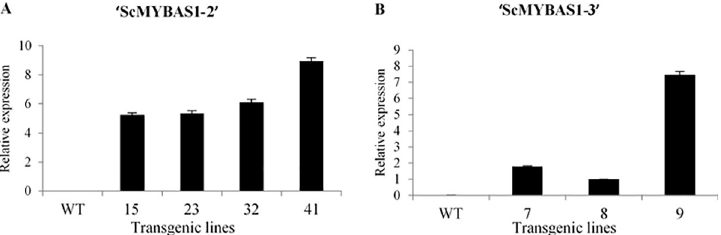
Fig 4. Relative expression of ScMYBAS1 gene in transgenic rice lines and wild type (WT) under greenhouse conditions. The leaves of 3-week-old seedling weres sampled for RNA extraction. Relative expression levels were obtained from the ratio of transgenic line with the lowest expression level and the other transgenic lines. Elongation factor 1 alpha ( eEF1a ) was used as a housekeeping gene. A, transgenic ScMYBAS1-2 lines; and B transgenic ScMYBAS1-3 lines used in physiological and biometric analyses. The values are mean ± SE (n = 3).